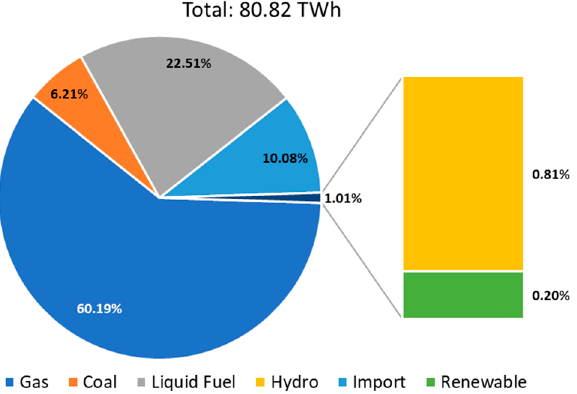
Figure 1. Shares of primary sources of electricity generation in Bangladesh in the financial year of 2020/21. Import indicates electricity imported from other countries. Data source: [9]